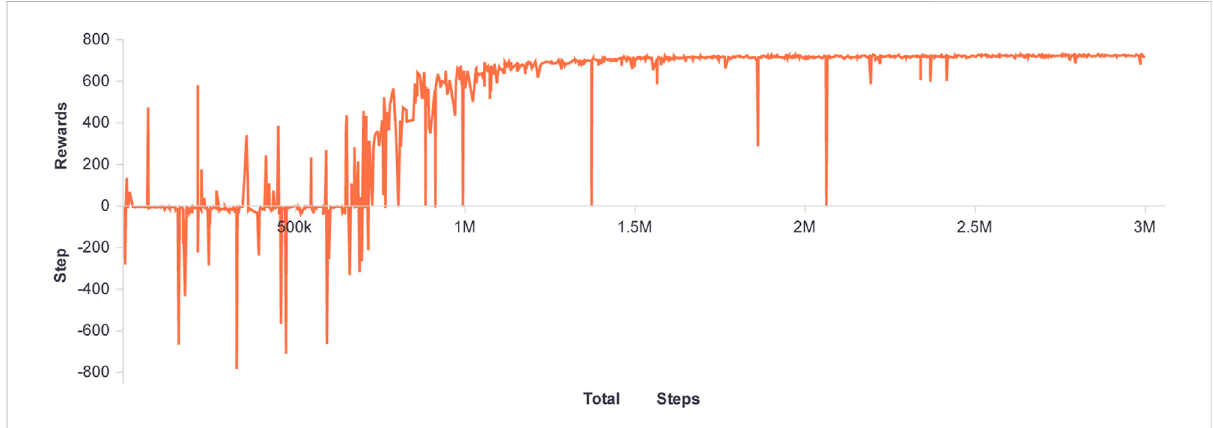
FIGURE 4 The rewards of evert step.